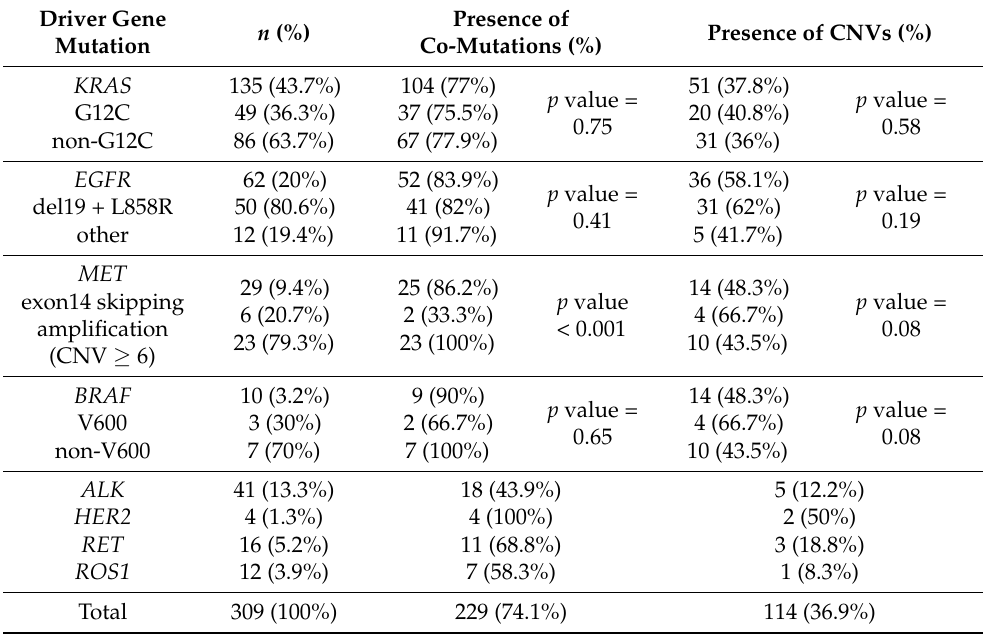
Table 1. Frequencies of co-mutation and concurrent copy number gain variants in the eight actionable gene